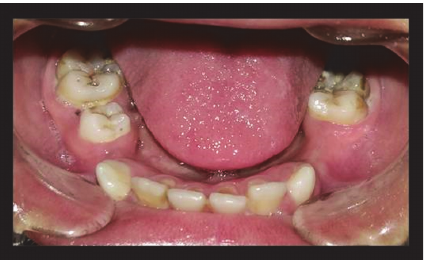
Figure 6: Three-year follow-up view with erupted permanent